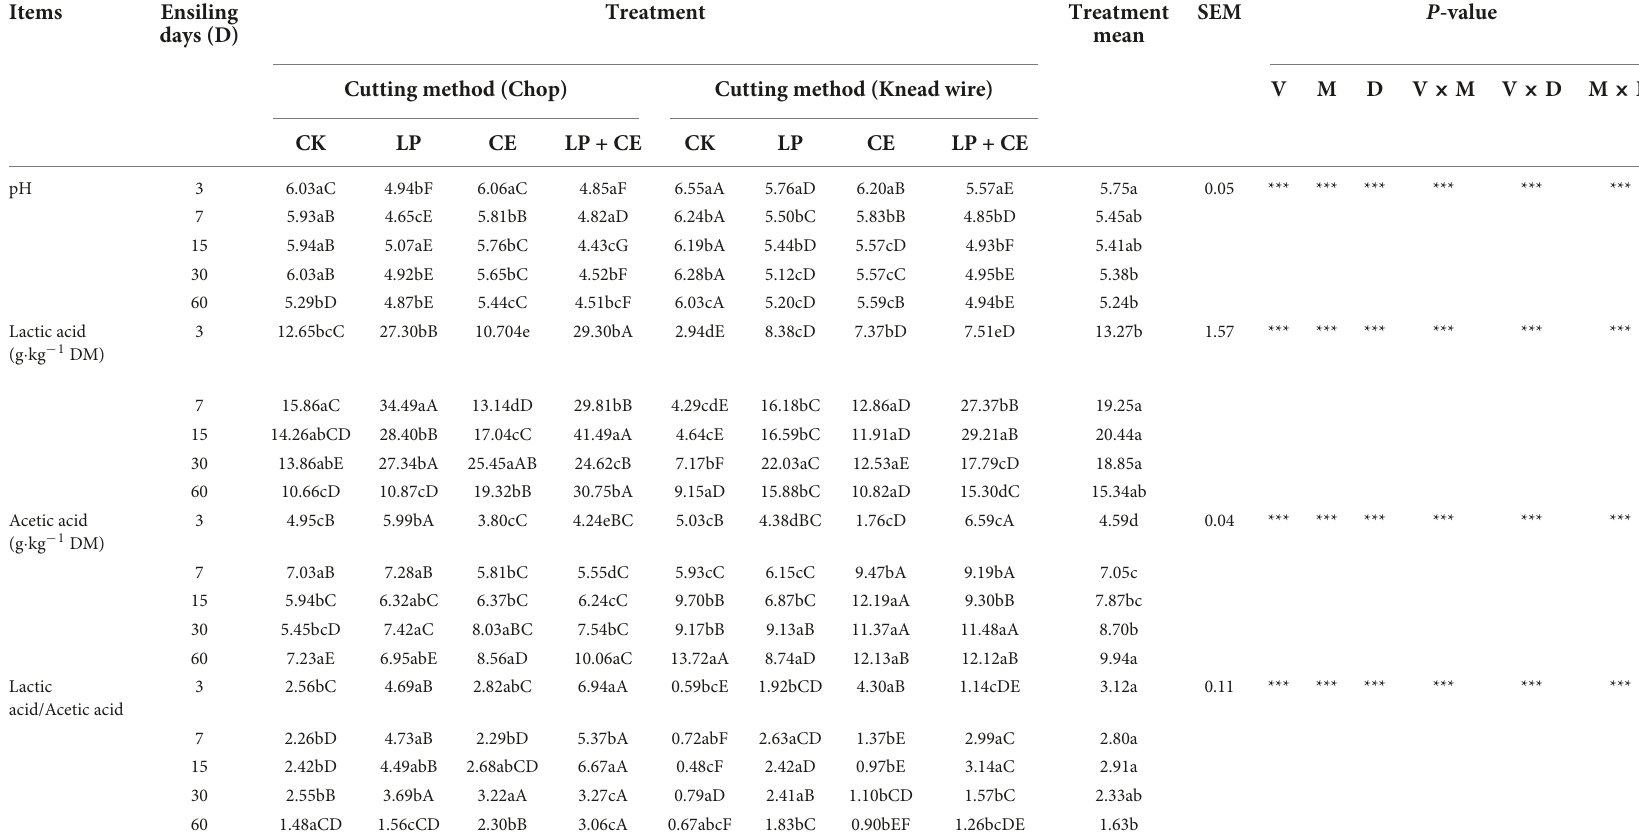
TABLE 2 Fermentative profile of Saccharum arundinaceum silage subjected to different cutting methods and additives during fermentation.